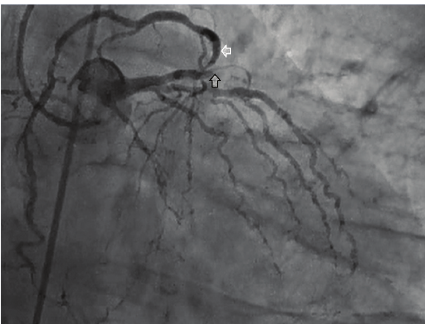
Figure 4: Left anterior descending coronary artery with total occlusion (black arrow) and right coronary artery from proximal segment of left anterior descending coronary artery (white arrow).